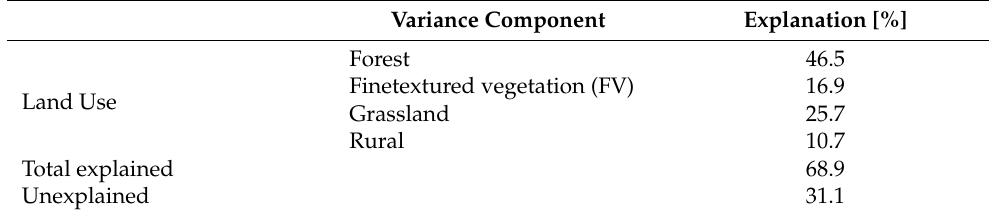
Table 5. Percentage of variance accounted for by land use, partitioned by a partial redundancy analysis. Variance Component